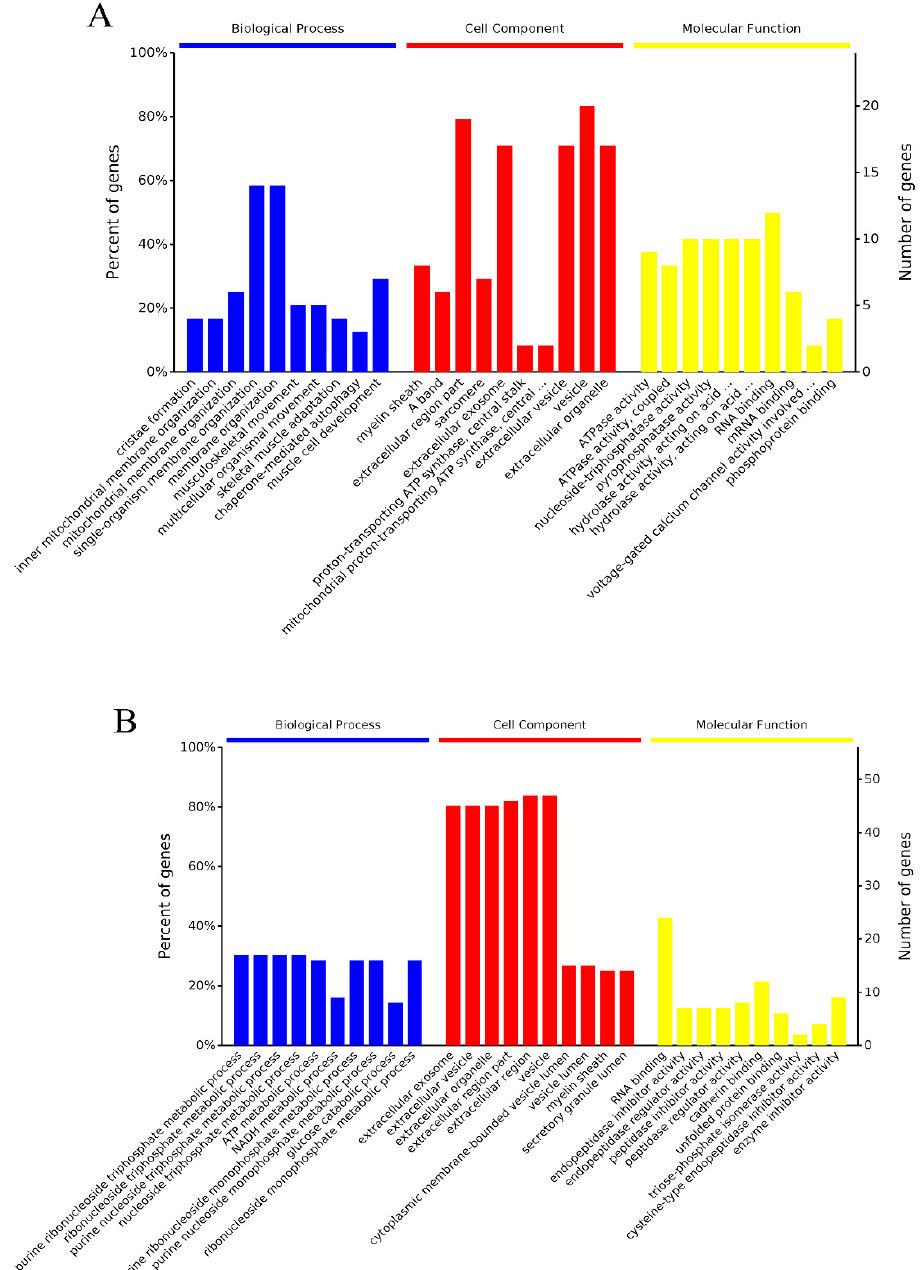
Figure 5. Gene Ontology (GO) enrichment analysis of differentially significant expressed proteins (DSEPs): ( A ) Day 0 vs. Day 6; and ( B ) Day 0 vs. Day 12. The x-axis represents the GO terms, while the y-axis represents the number of DSEPs in each category.